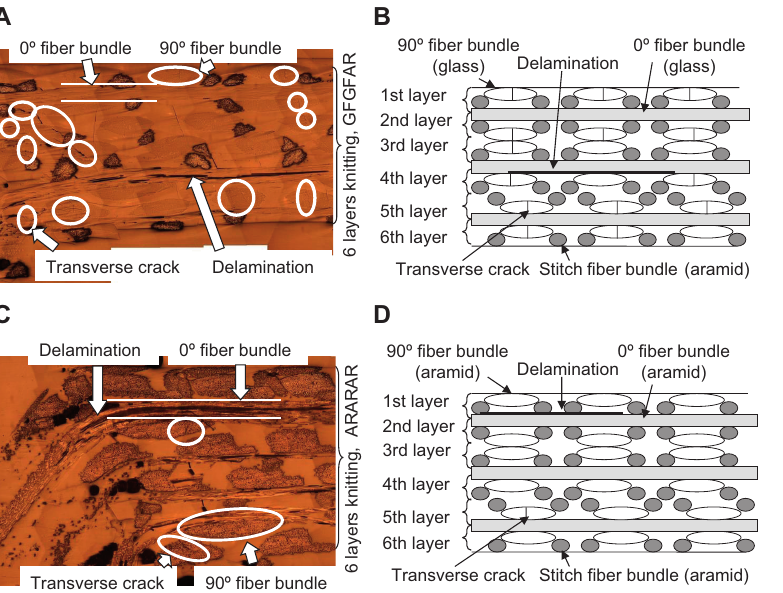
Figure 11 Enlarged view of cross-sectional photographs of the specimens after the plate bending impact test and schematic drawings: (A, B) GF-GF-AR and (C, D) AR-AR-AR; transverse cracks are indicated by circles.